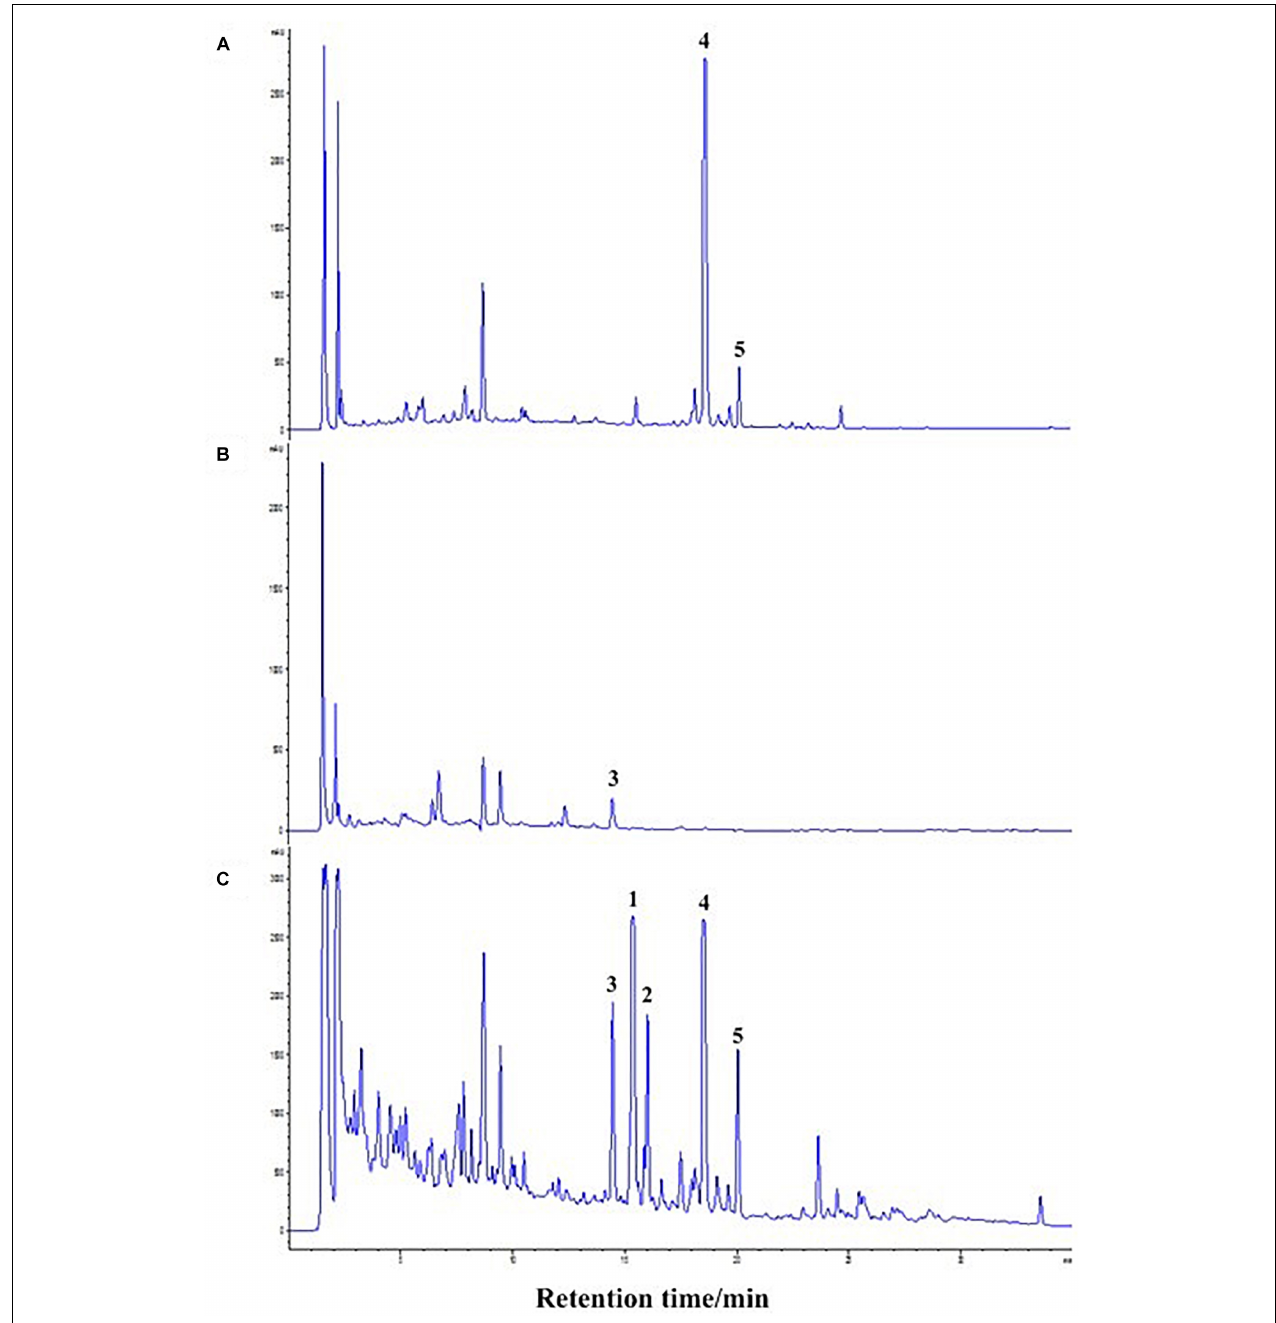
FIGURE 2 | High-performance liquid chromatography (HPLC) profiles of the EtOAc extracts of different culture approaches. (A) Pure culture of Streptomyces rochei MB037; (B) pure culture of Rhinocladiella similis 35; (C) co-culture of S . rochei MB037 and R . similis 35.